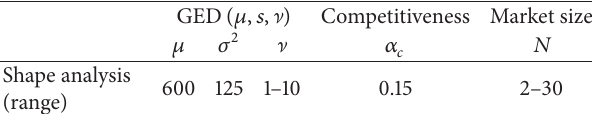
Table 2: Benchmark case for Section